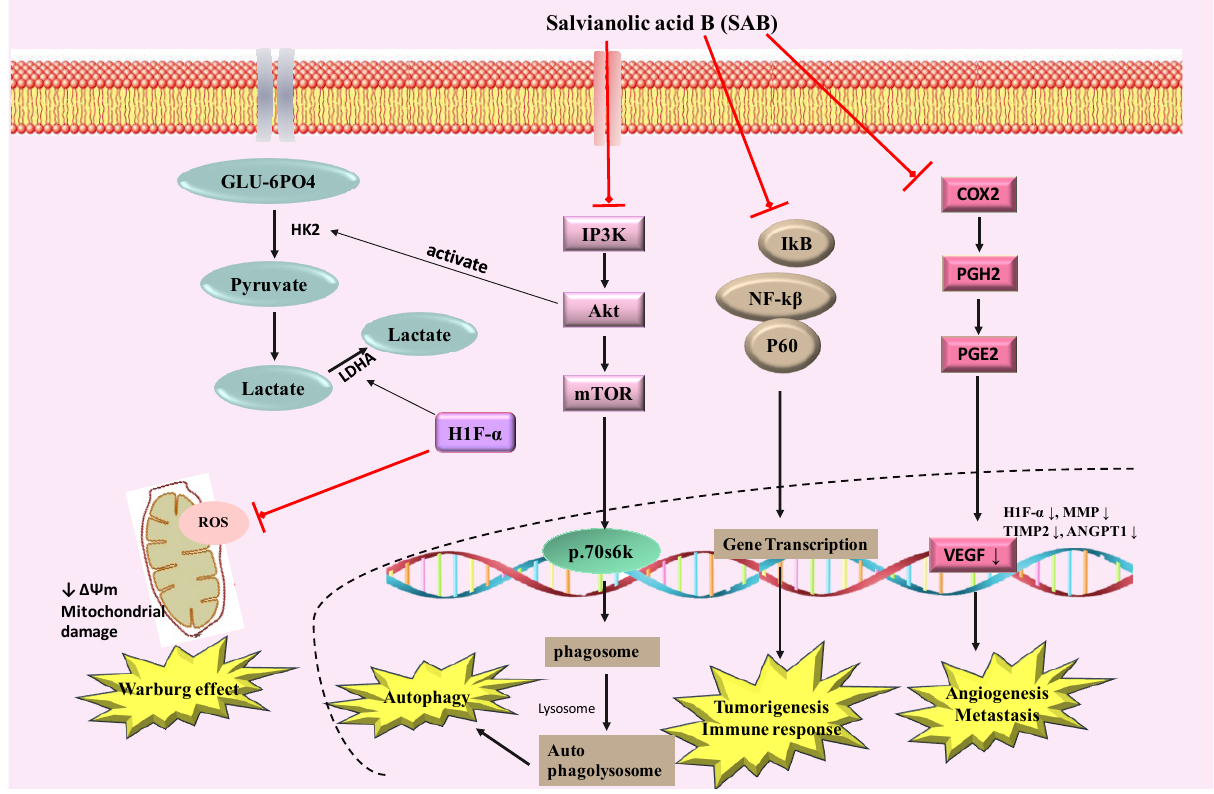
Figure 4. Schematic diagram showing SAB inducing mechanism of action in cancer. PGH2: prostaglandin H2; PGE2: prostaglandin E2; VEGF: vascular endothelial growth factor; MMP: matrix metalloproteinases; IP3K: indole phosphatide 3 kinase; GLU-6PO4: glucose 6 phosphate; ↑ increase; ↓